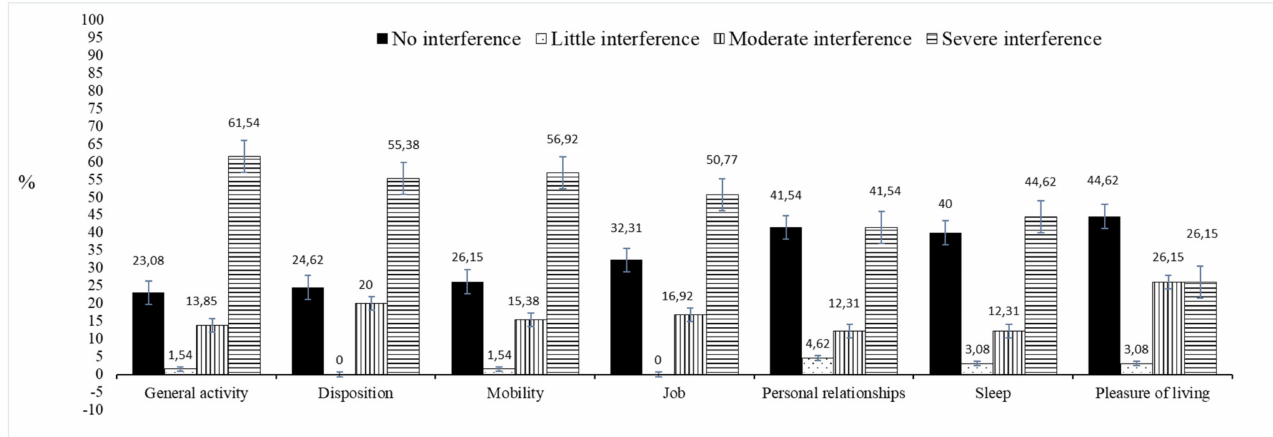
Figure 1. Prevalence of functional interference of pain in activities of daily living of patients with chronic kidney disease undergoing hemodialysis ( n =